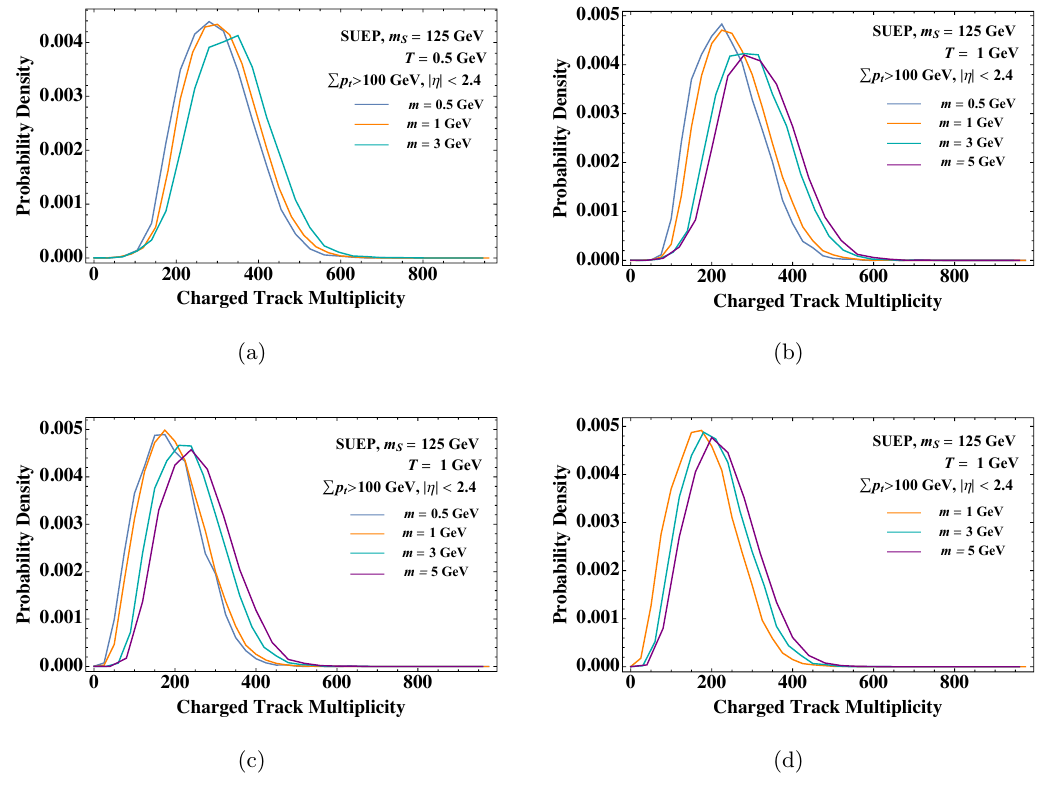
Figure 30 . The same as (cid:12)gure 30 but for the charged track multiplicity. For (cid:12)xed T , larger meson masses m yield higher multiplicity events.